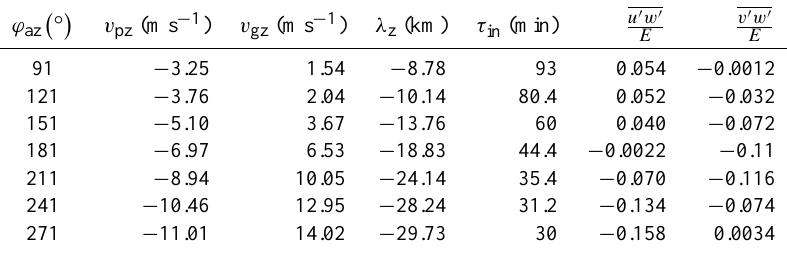
Table 4b. Same as Table 4a except that the parameters of the gravity wave are τ = 45min, v ph = 60ms − 1 , λ h = 162km, and u h = 30 . 9ms − 1